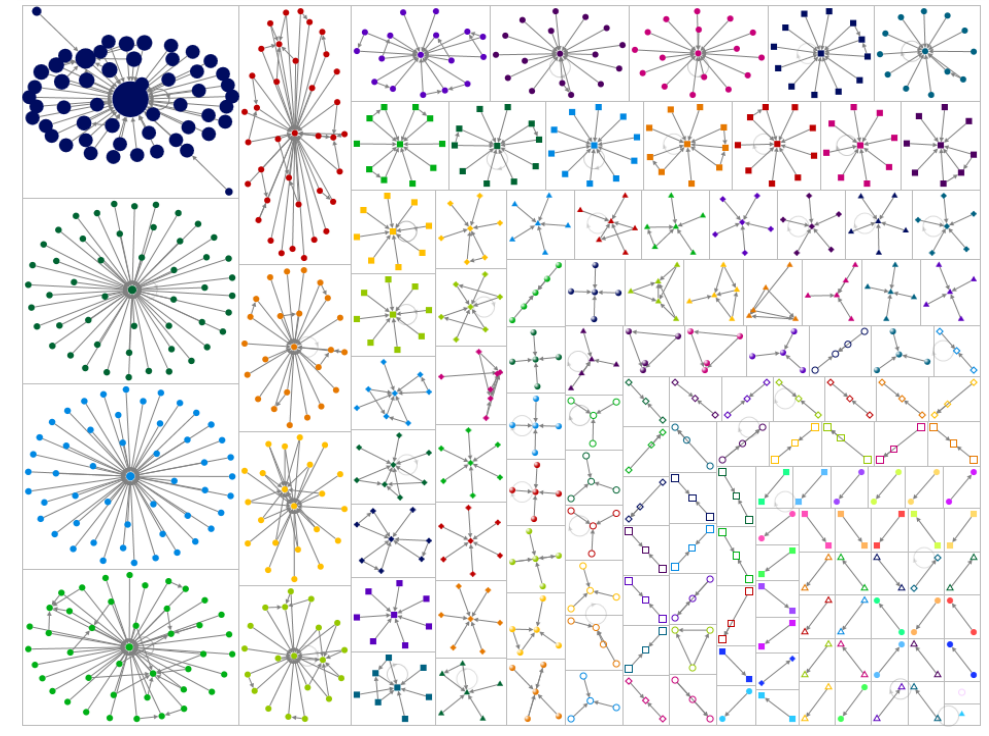
Figure 3. Visualizations of the types of networks that emerged from the social network analysis.